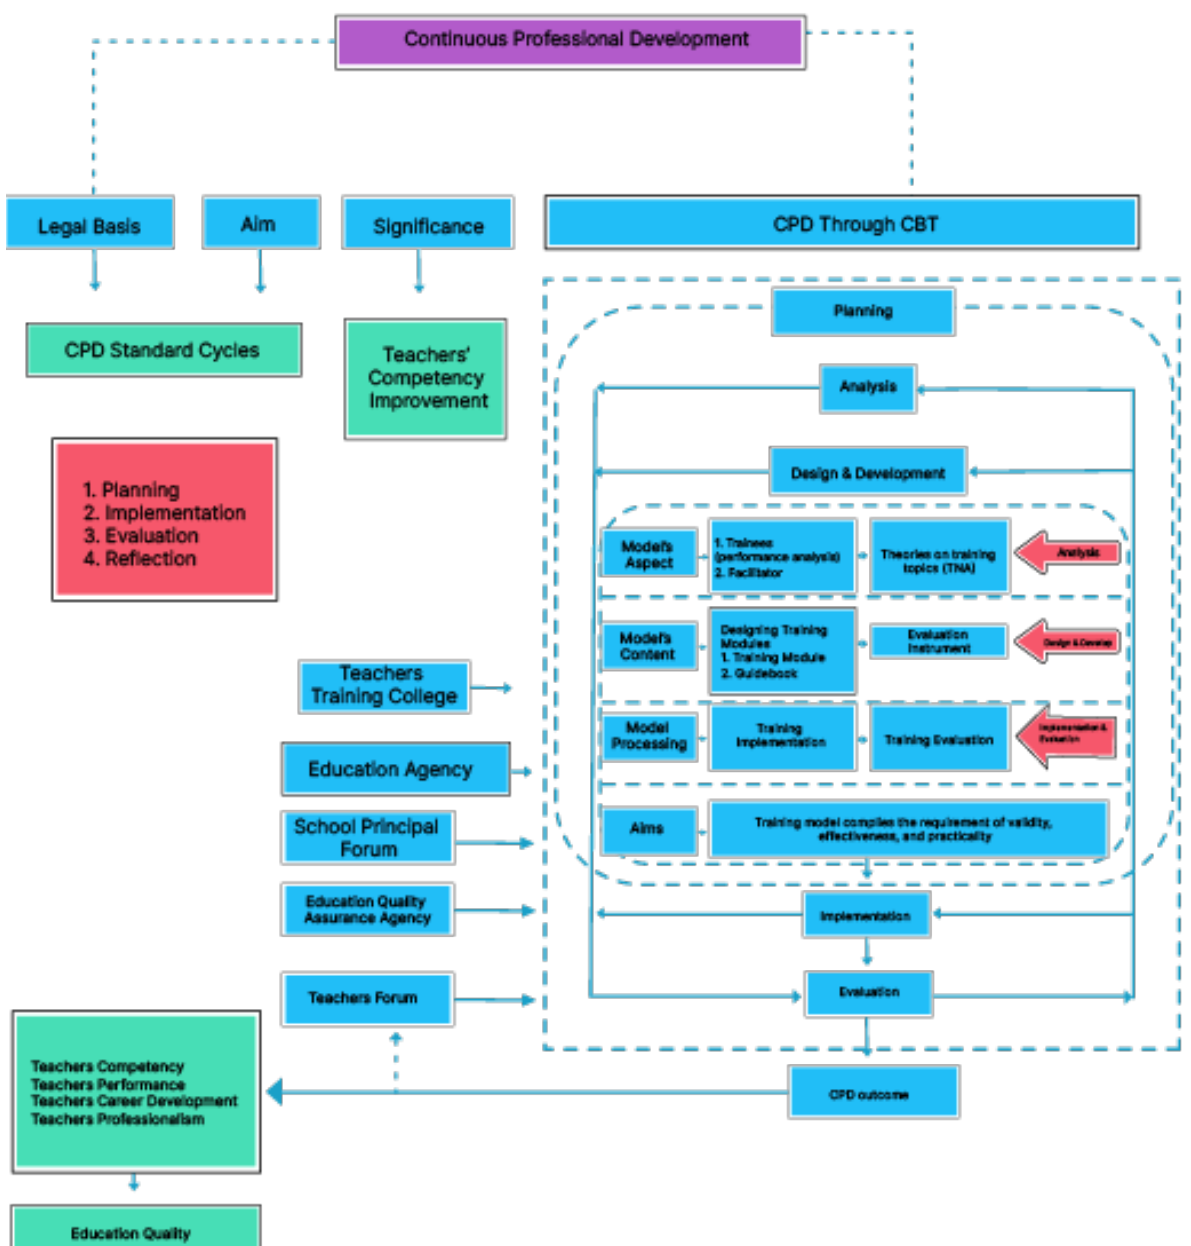
Figure 4. Initial model of CPD through